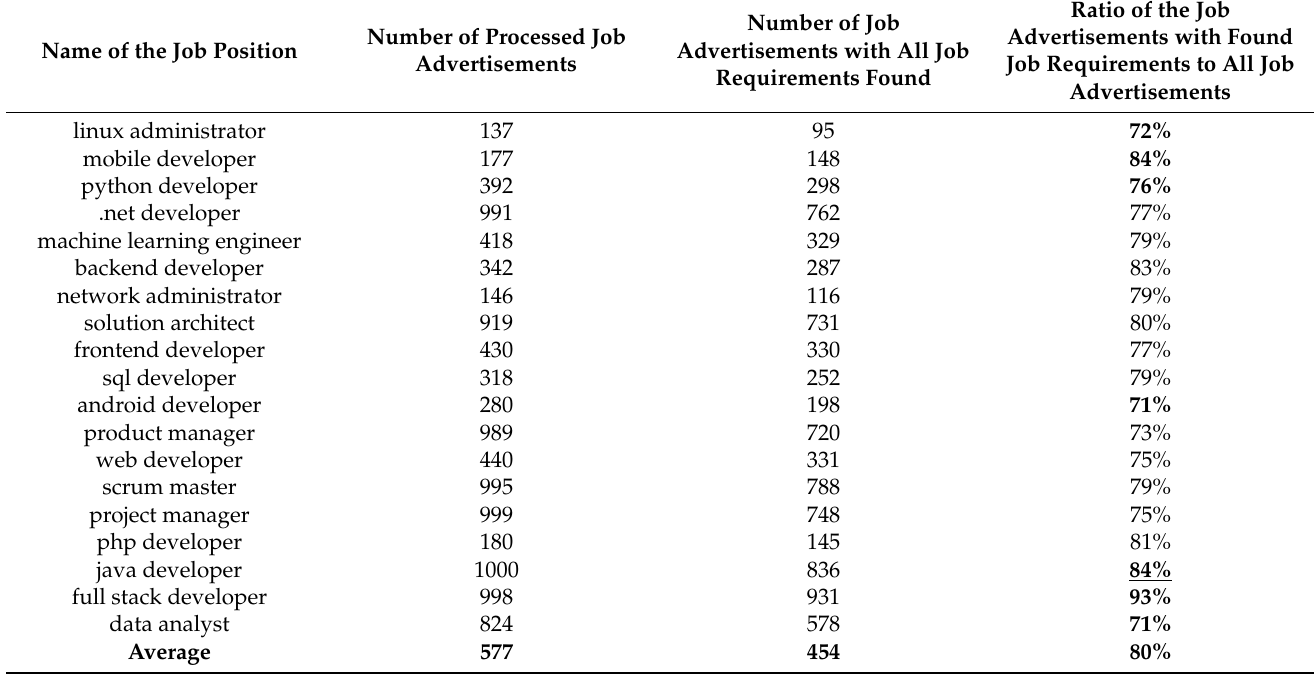
Table 5. Results of processing job advertisements using the machine learning with improved marking lists